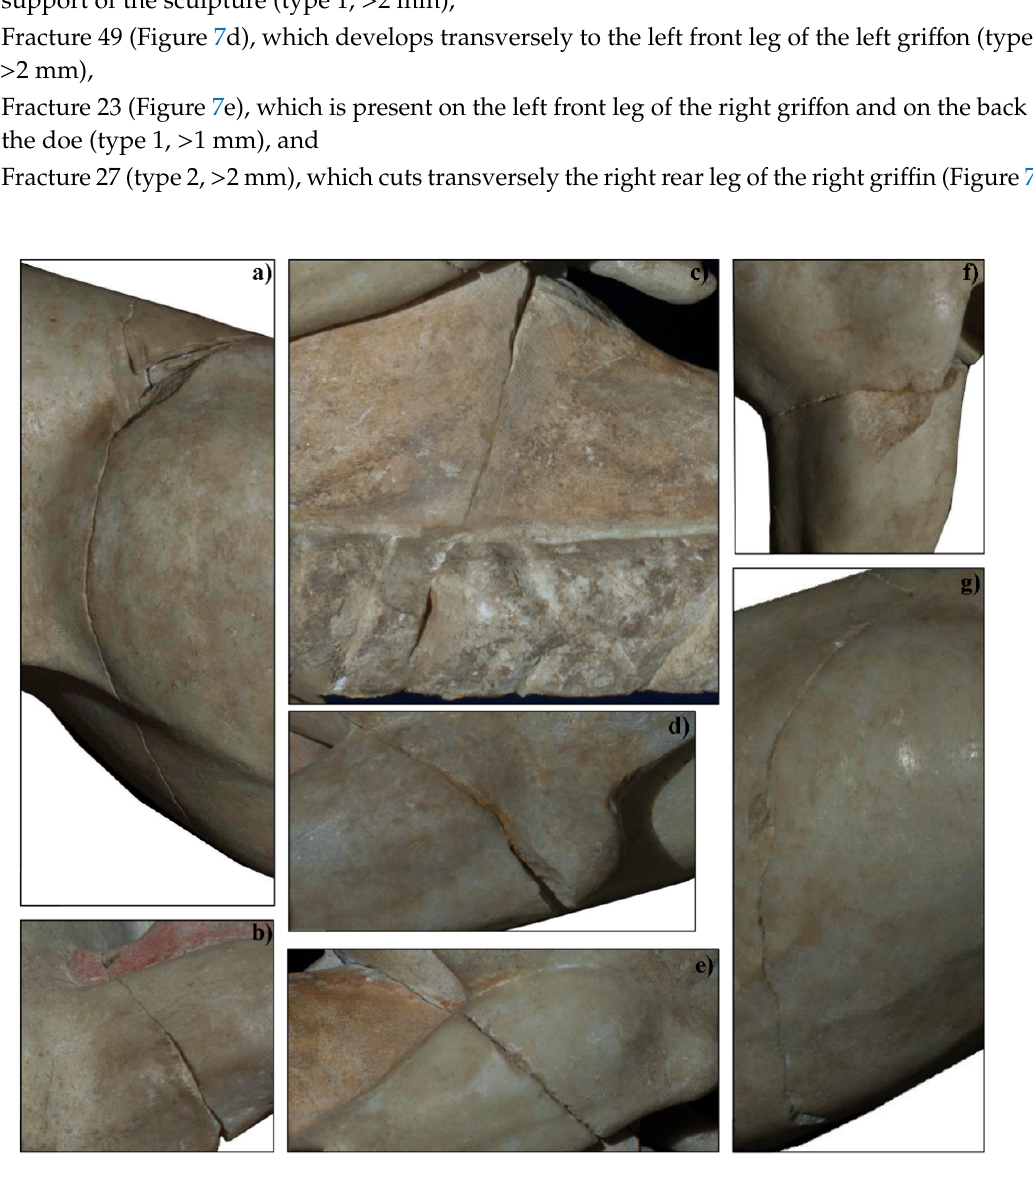
Figure 8. Indication of the more vulnerable areas of interest by the cracking phenomena: front side ( a ), back side ( b ), and top ( c ).